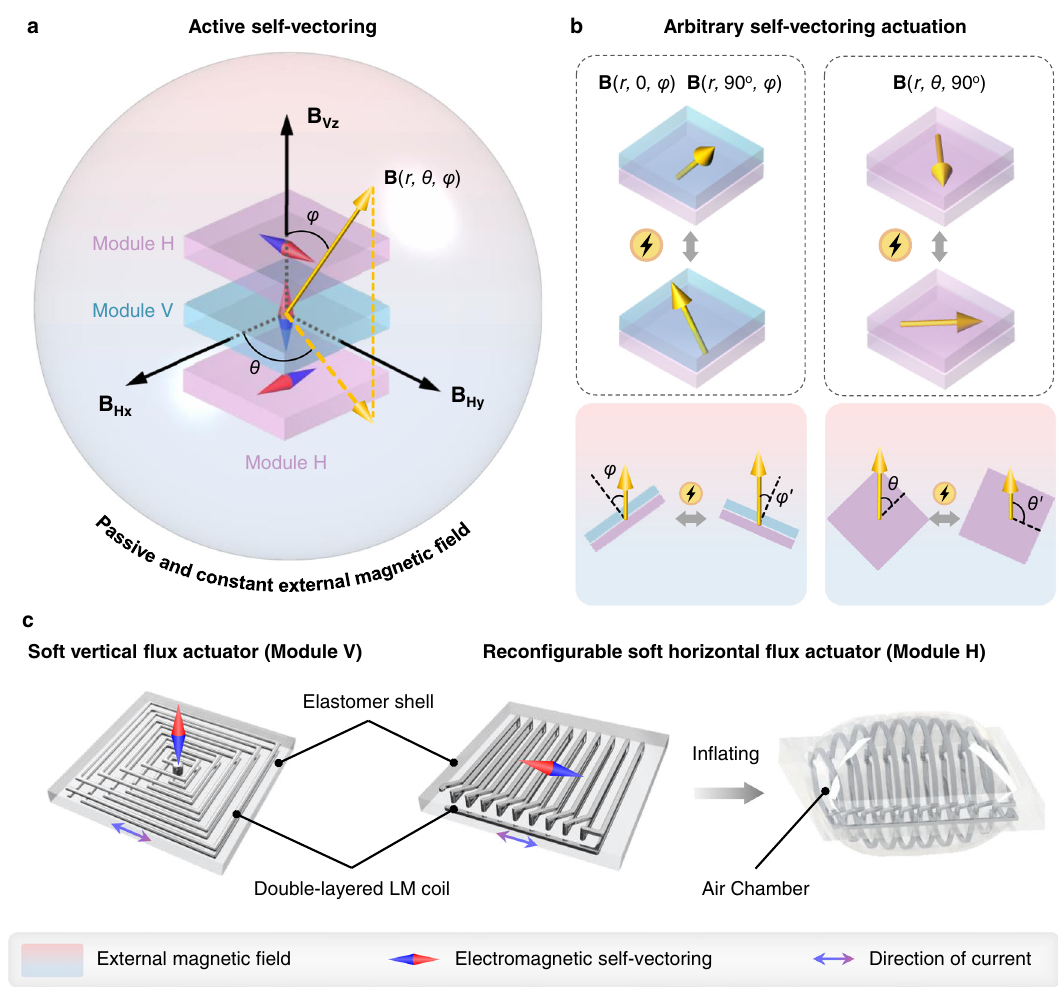
Fig. 1 | Concept of self-vectoring and the elementary soft actuator modules of SESRs. a Schematic of active self-vectoring of the SESRs. The sphere space with gradient from blue to red represents the passive and constant external magnetic fi eld.Threemodules(twoelementarymodules:moduleVwithaverticalEV,module H with a horizontal EV) in the sphere space can synthesize any EVs in theory. b Design principle of self-vectoring control for SESRs. Combination of two ele- mentary modules can constitute new composite actuators with arbitrary EVs as applyingcurrentsignalscaneasilyandinstantlyadjusttheinteriorEVsineverysub- domain of the robots, thus resulting arbitrary self-vectoring actuation in passive